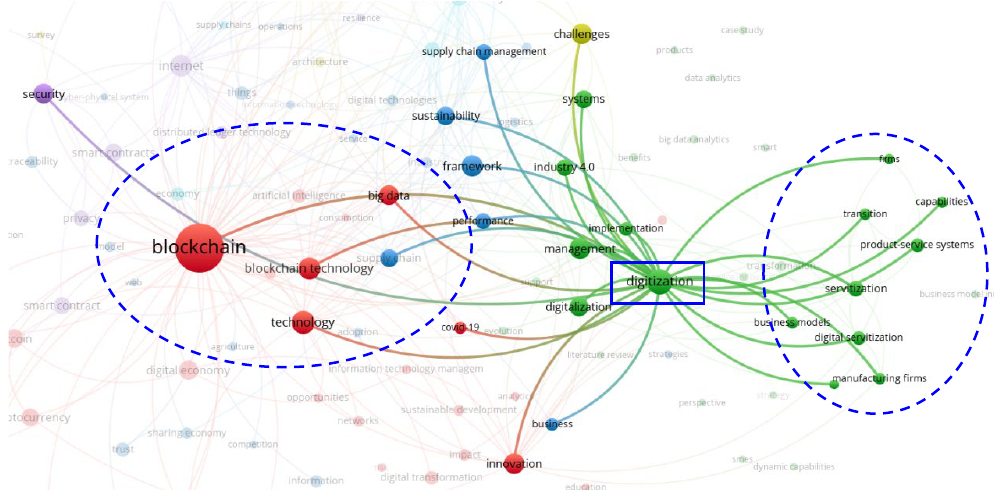
Figure 4. Keywords co-occurrence network visualization of PSSs and BC in the context of digitiza- tion and digital economy (generated by authors).